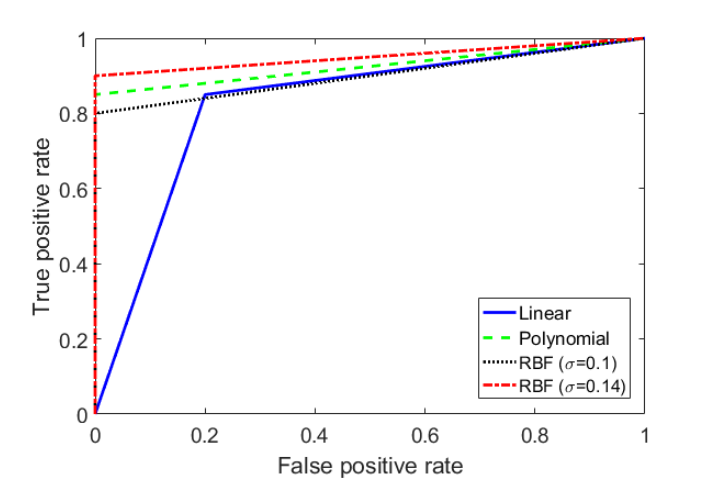
Figure 9. ROC curve comparison for different SVM classifiers.